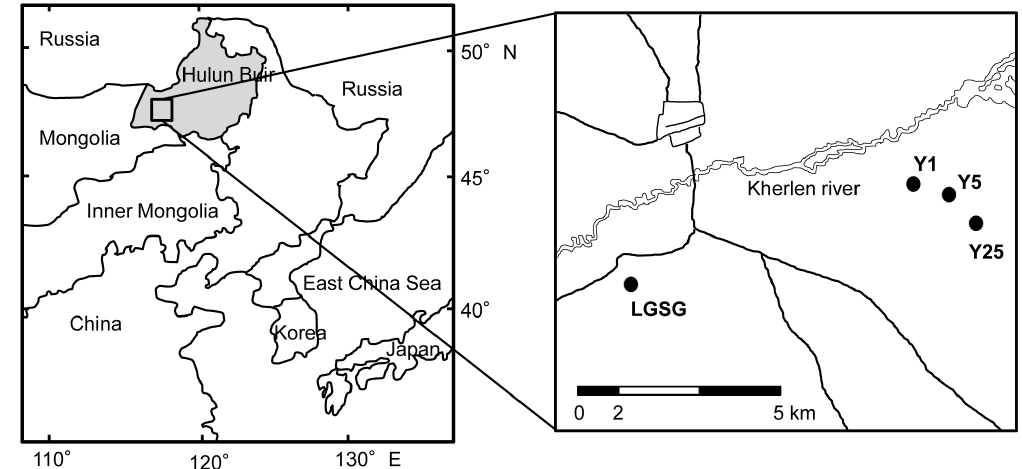
Figure 1. Map of the study area and the 4 study sites ( N ) in Hulun Buir.